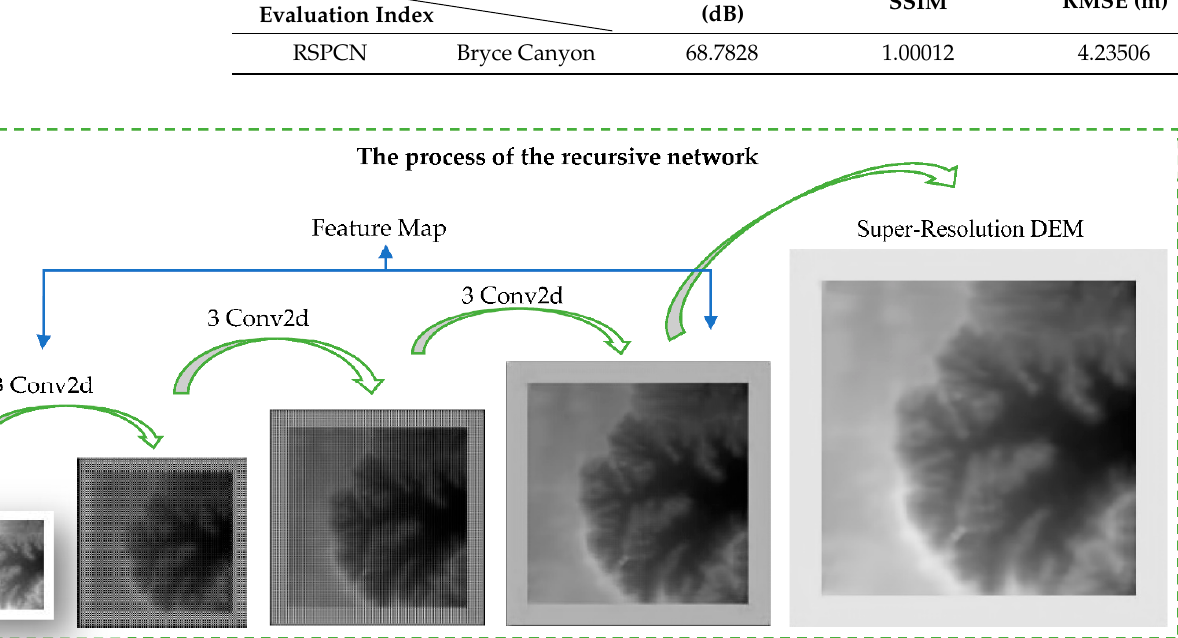
Figure 14. The process of RSPCN with finer density of pixels.